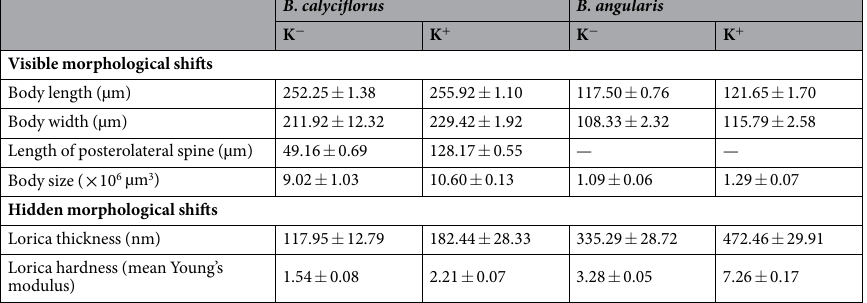
Table 1. Biometric characters of Brachionus calyciflorus and Brachionus angularis cultured in the medium with and without Asplanchna kairomones. Data are mean ± S.E. based on five replicated populations. K − = rotifer culture medium without Asplanchna kairomones. K + = rotifer culture medium with Asplanchna kairomones at a concentration of 100 Asplanchna L − 1 with 24 h exposure.